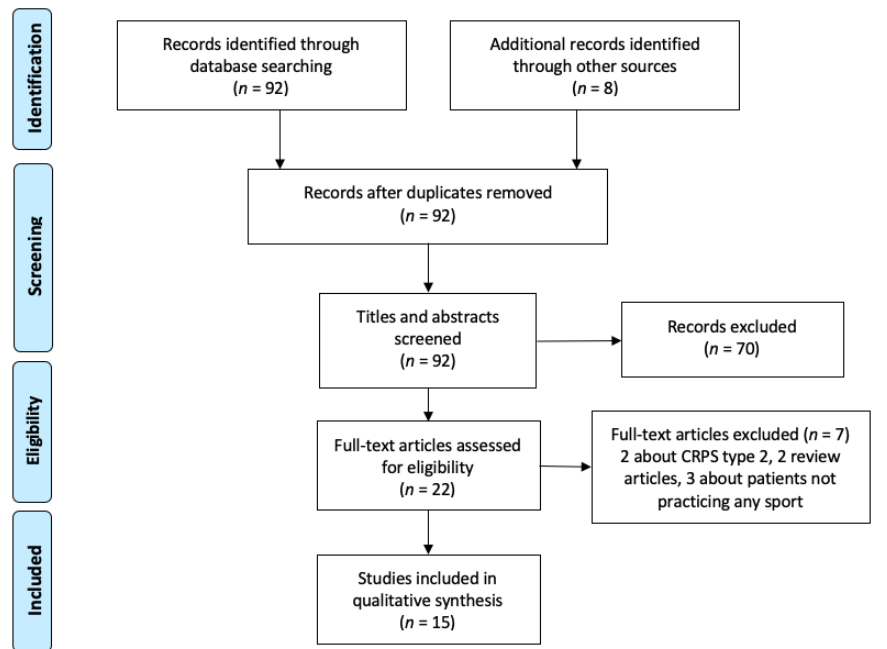
Figure 1. Flow diagram of the literature review process. After applying the paper selection criteria, we checked 21 full texts and excluded 2 articles dealing with CRPS type 2, 2 review articles, and 3 articles dealing with patients not practicing any sport. Finally, the selected articles were 15. Table 1 shows main charac- teristics of each study. Table 1. Main characteristics of selected articles.